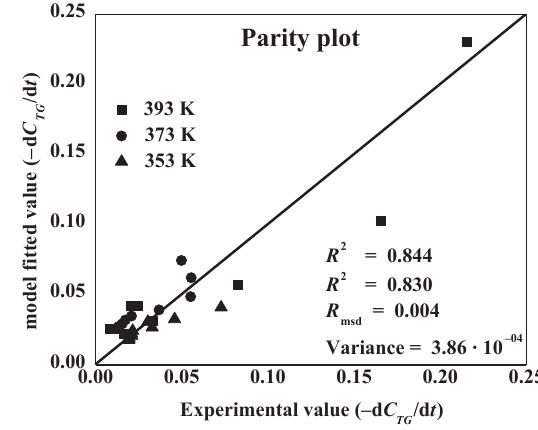
Fig. 10 – FAME yield from Karanja oil at different reaction times showing the effect of temperature. Reaction conditions: catalyst amount = 18 wt% of oil; temperature = 393 K; rpm = 750; time = 8 h; methanol:oil = 6:1, reaction mixture volume = 341 mL.